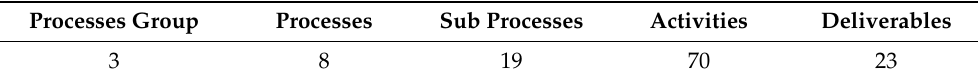
Table 5. The content of the global engineering process in terms of the number of processes, subpro- cesses, activities, and